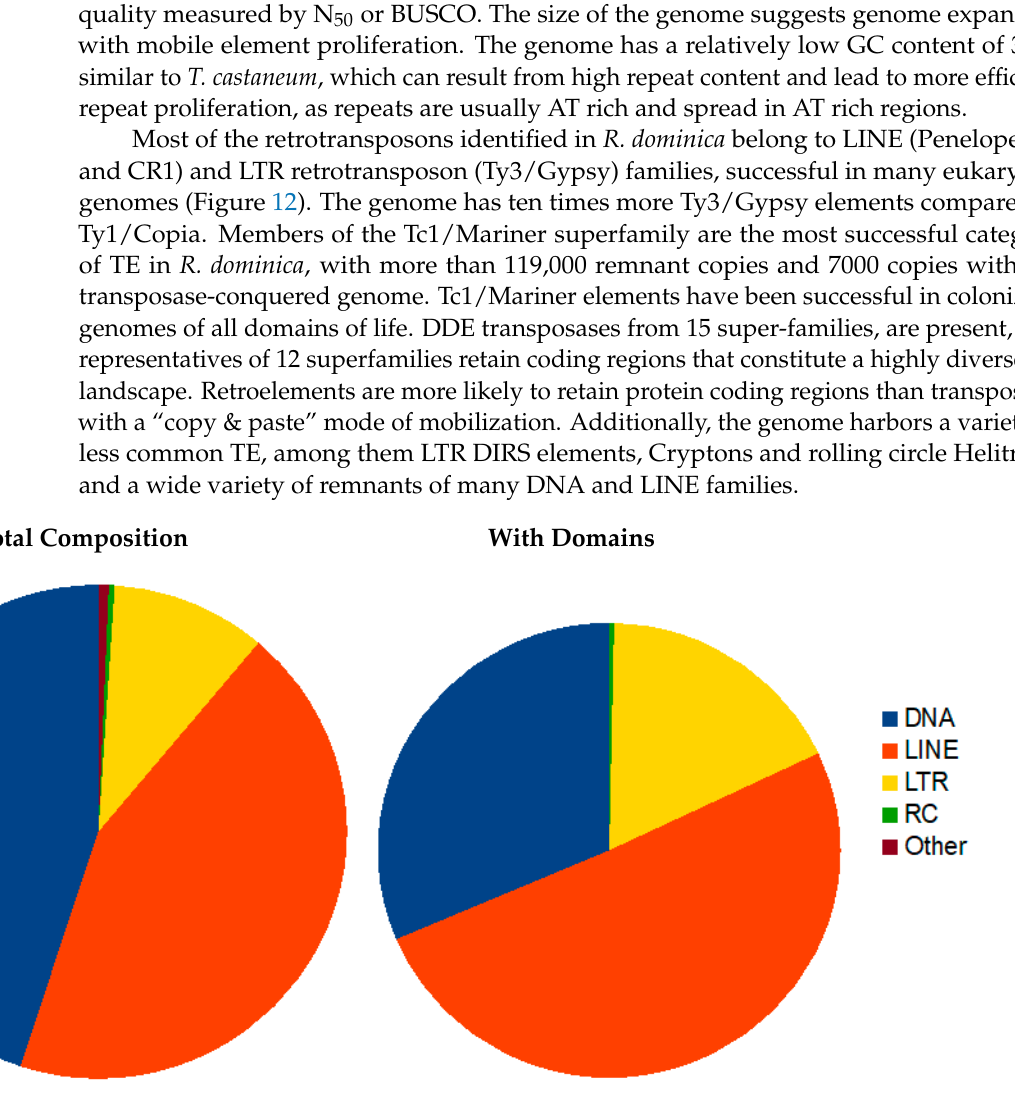
Figure 12. Composition of the transposable elements (TE) in the genome of R. dominica.